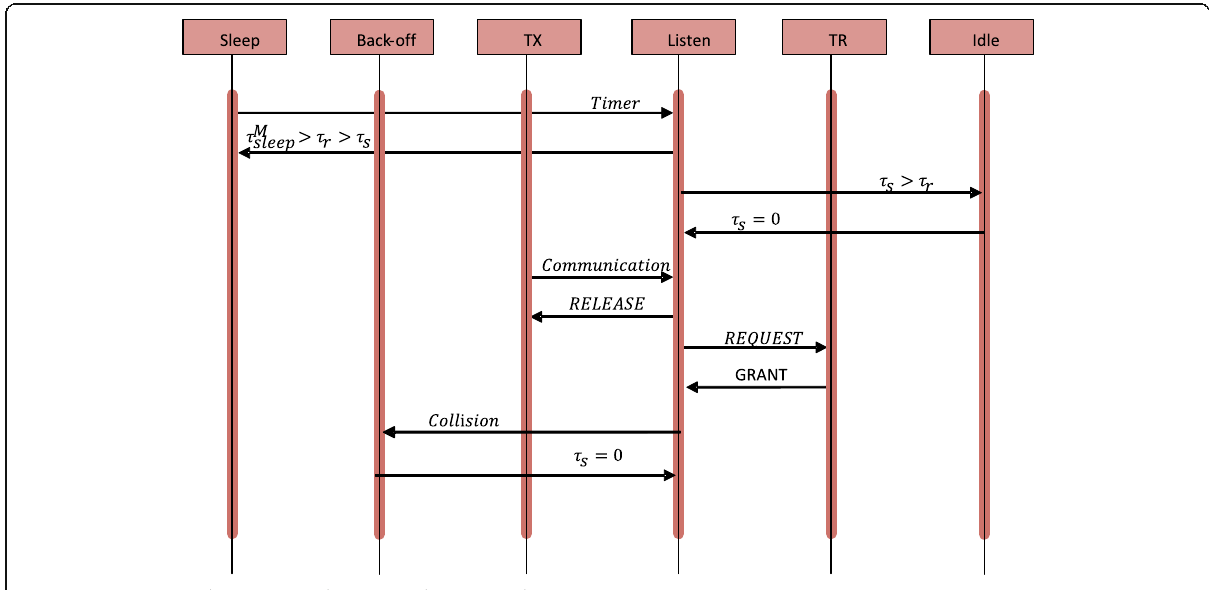
Fig. 8 State transition diagramme in the proposed AEH-MAC